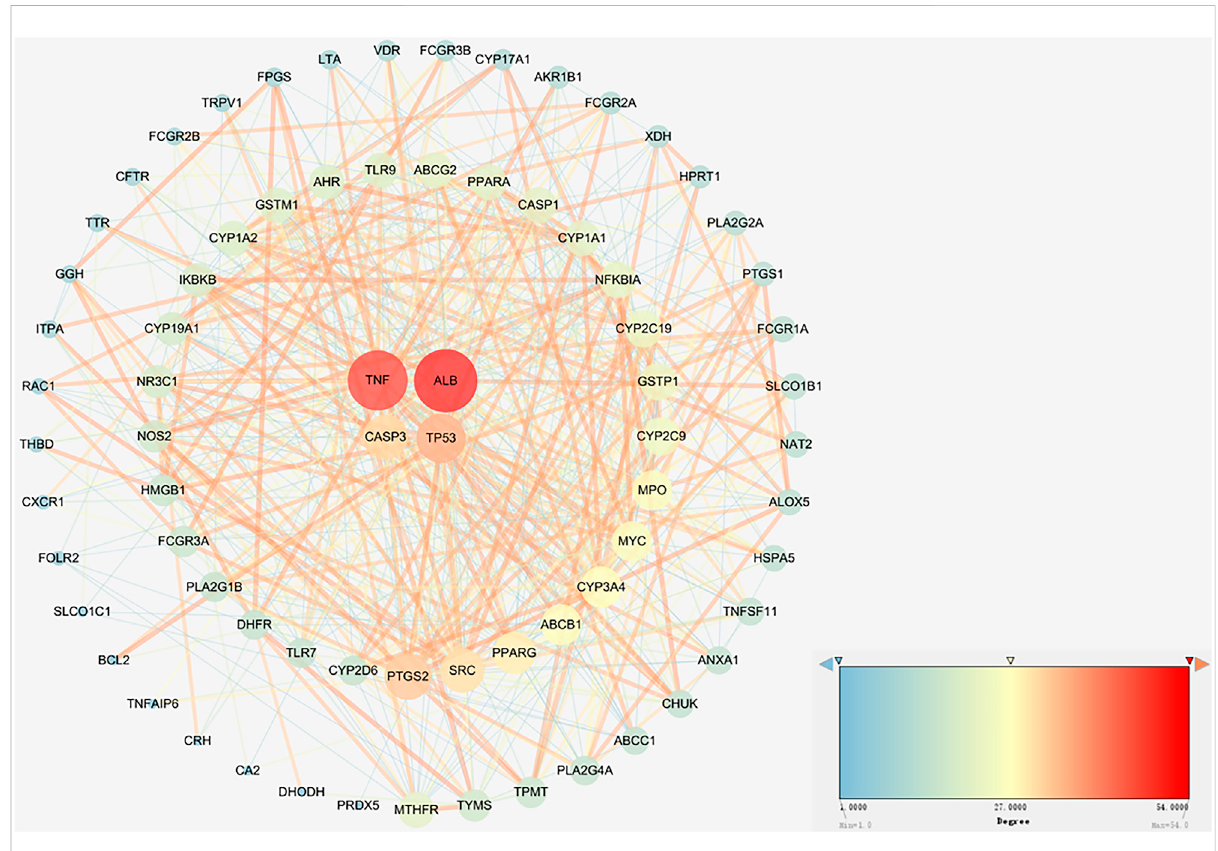
FIGURE 3 Network analysis of protein interactions. A circle represents an overlapping gene. The larger the node size and the redder the color, the higher the degree